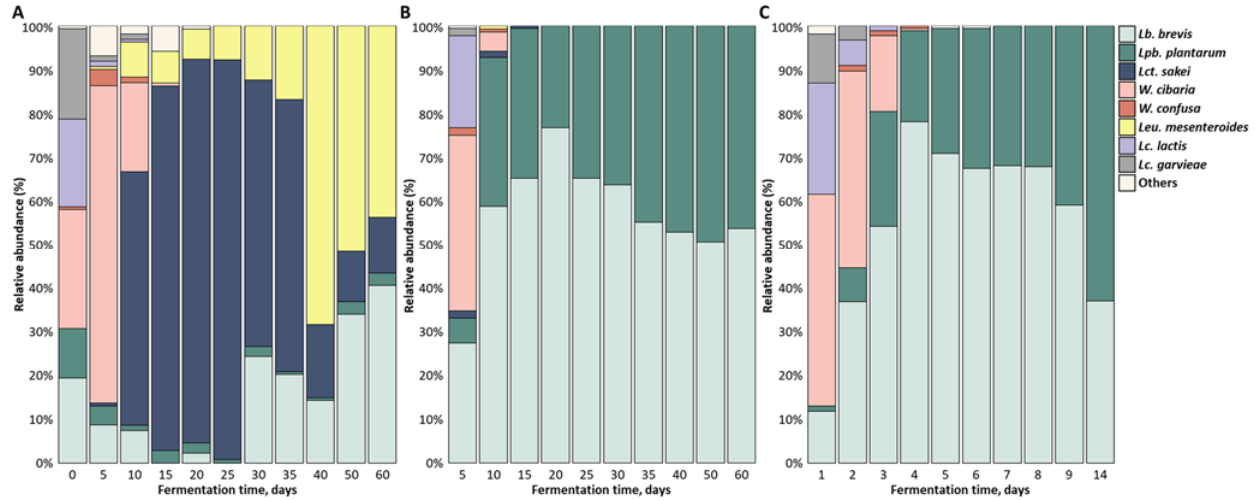
Figure 5. Changes in the microbial communities during the fermentation at ( A ) 4 °C, ( B ) 10 °C, and ( C ) 23 °C. The others indicate species with a prevalence of <0.4%, including Lc . raffinolactis , Leu . lactis , P . ethanolidurans , E . sulfureus , E . cloacae , E . ludwigii , E . aerogenes , and S . simulans .